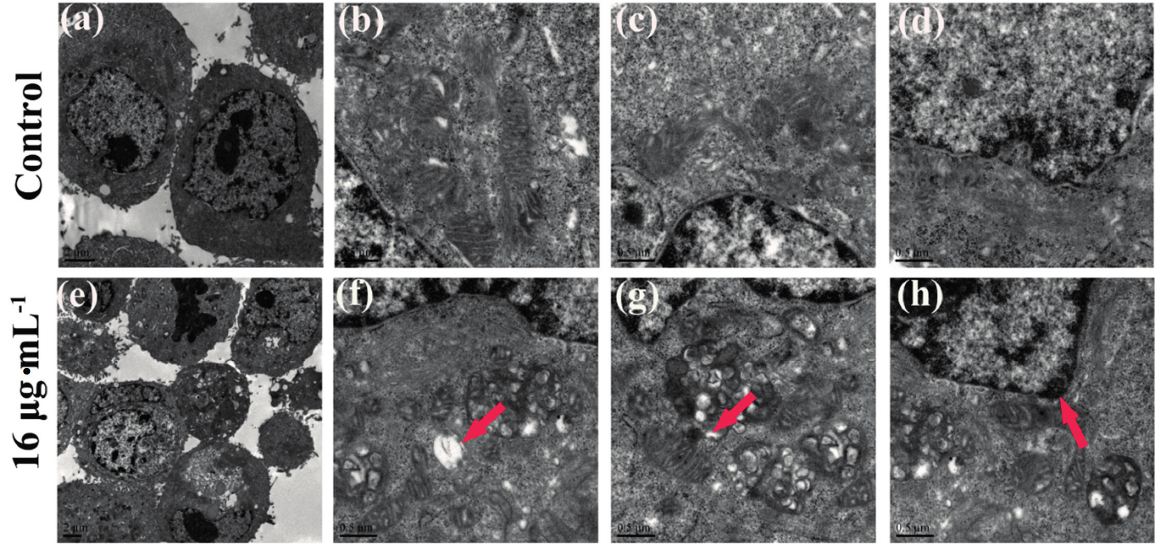
Figure 7. TEM images of cell ultrastructure of IEC-6 cells before ( a – d ) and after ( e – h ) treatment with kansenone of 16 µg·mL − 1 for 48 h. Red arrow in ( f ) showed the mitochondria vacuoles. Red arrow in ( g ) showed broken mitochondria crista. Red arrow in ( h ) showed nuclear chromatin